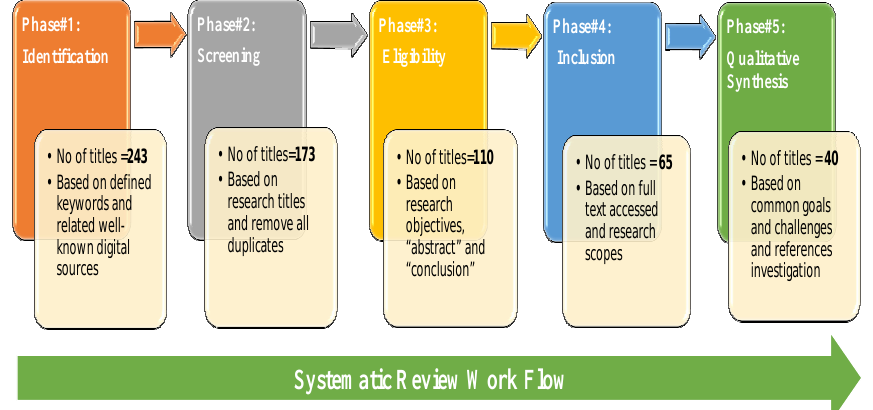
Figure 4. Quality assessment review flow